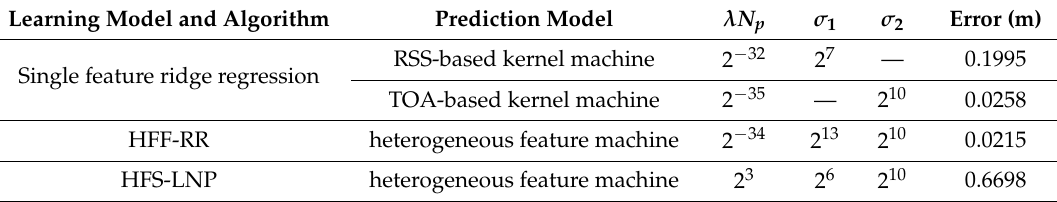
Figure 6. Estimation of trajectory simulated several times by heterogeneous feature machine and single feature-based kernel machines learned by different learning algorithms in absence of noise. Table 3. Performance comparison of heterogeneous feature machine and single feature-based kernel machine learned by different algorithms in absence of